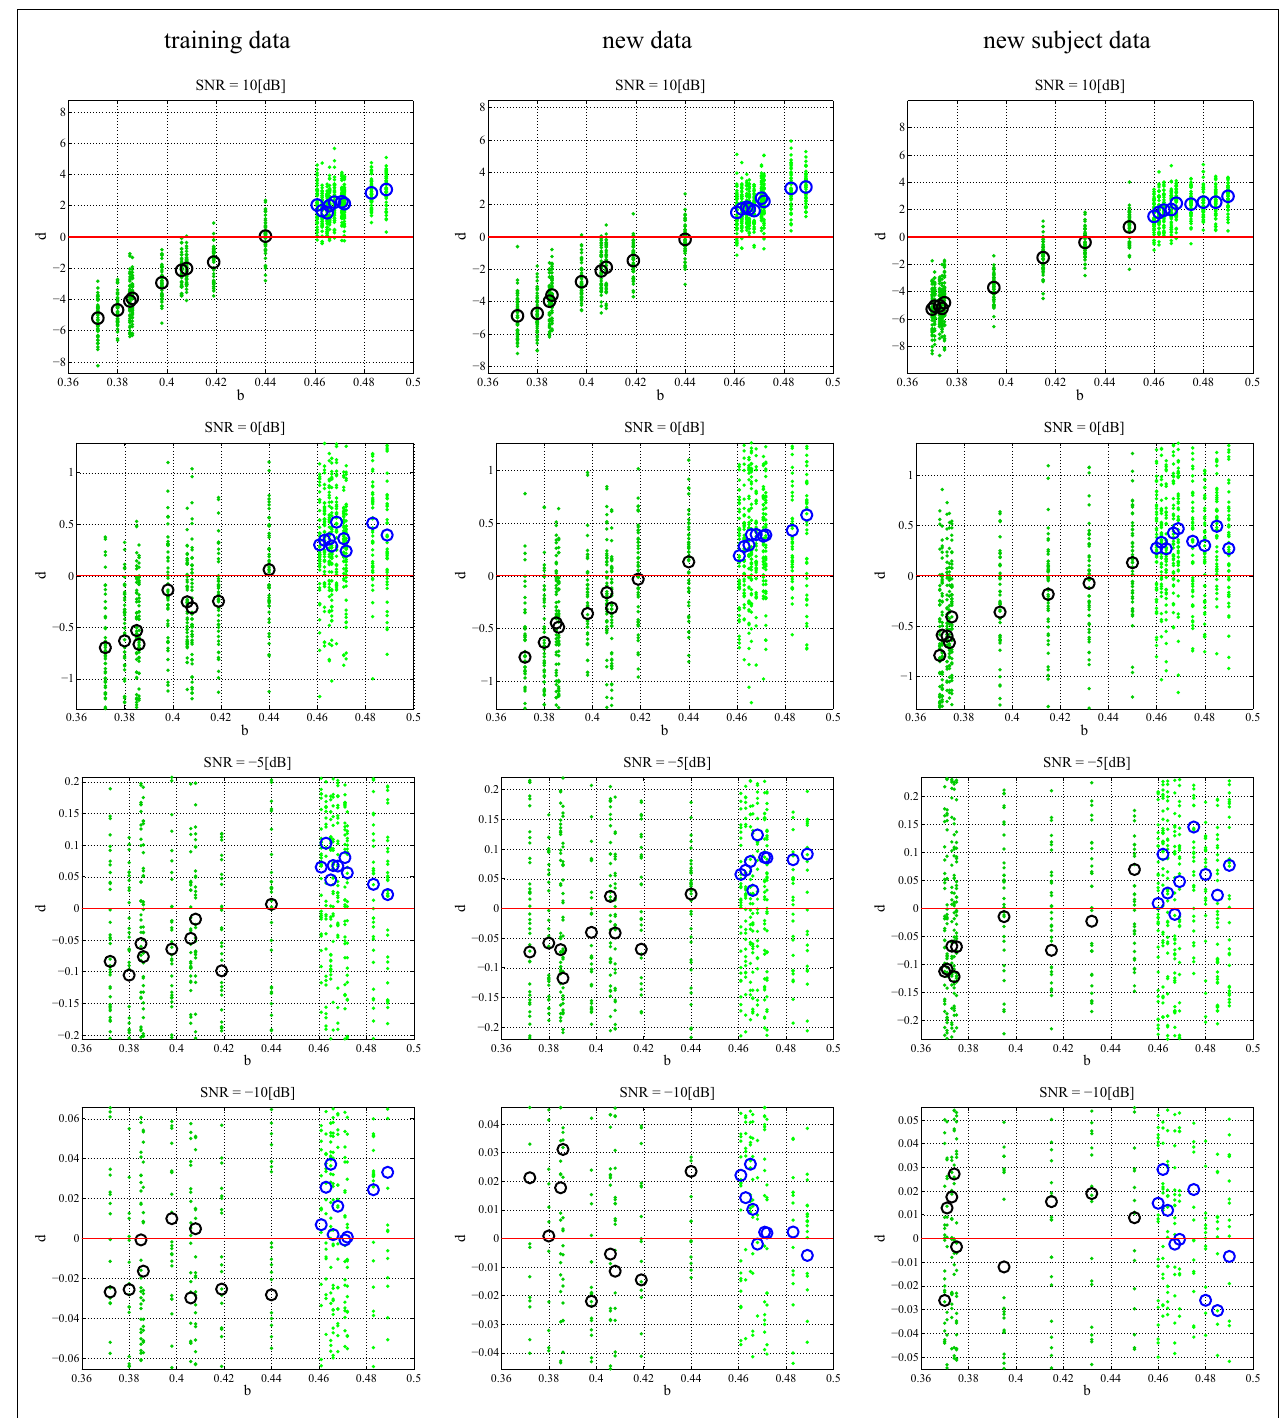
PD and blue circles correspond to CO groups.The performance of the DDE classification algorithm on the training data, new data, and new subject data is plotted from left to right respectively. SNR ranges 10: − 10dB and decreases from top to bottom.The system shows noise invariance up to − 5dB after which the ability to discriminate between the two classes decreases dramatically. At high SNR the bifurcation parameter b is linearly correlated to the output d